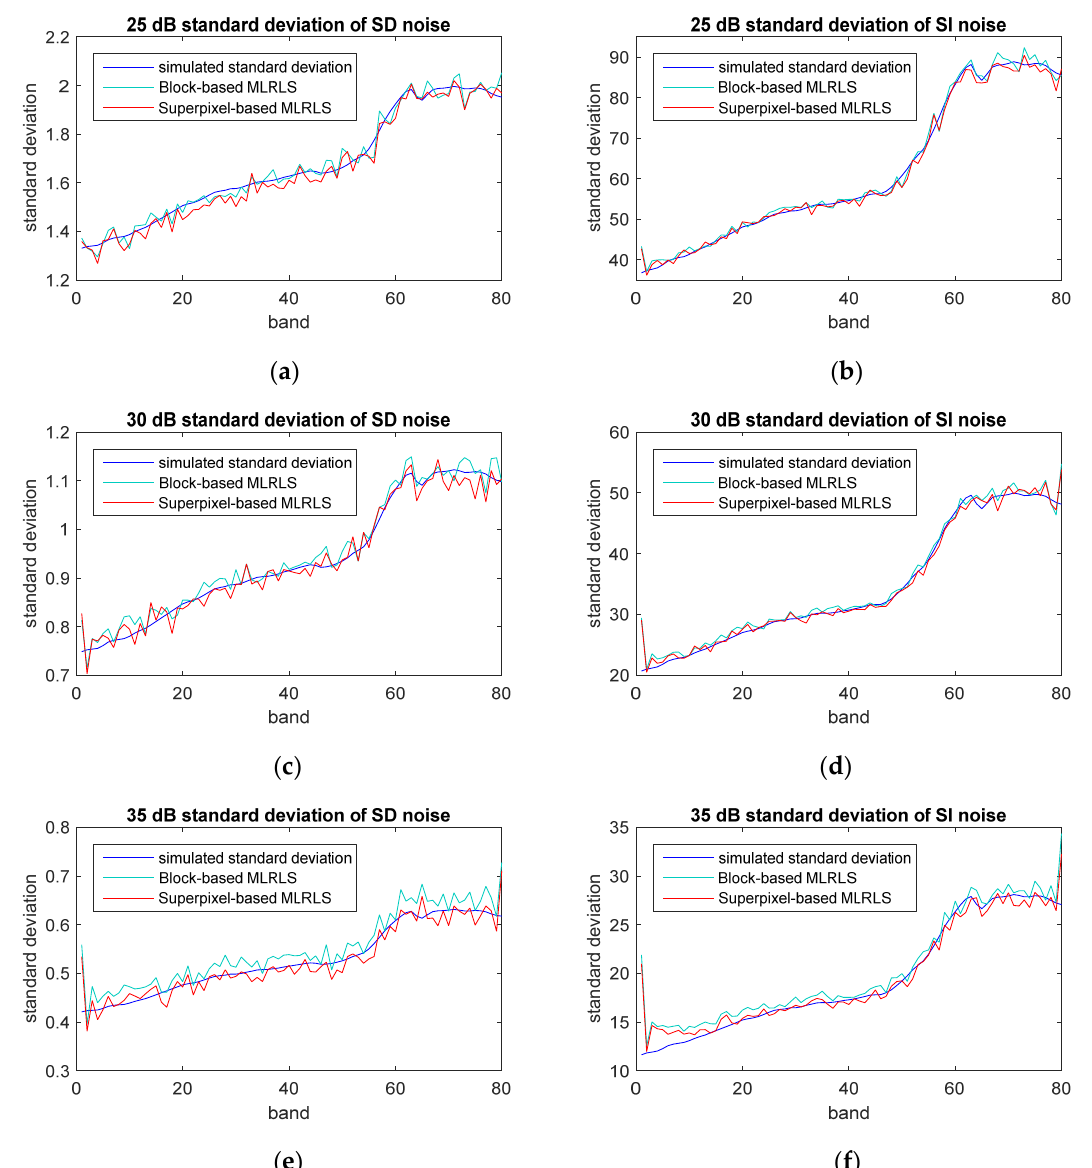
Figure 9. The standard deviation of noise in each band with α = 1 : 1: ( a ) 25 dB, SD noise; ( b ) 25 dB, SI noise; ( c ) 30 dB, SD noise; ( d ) 30 dB, SI noise ( e ) 35 dB, SD noise; and ( f ) 35 dB, SI noise.